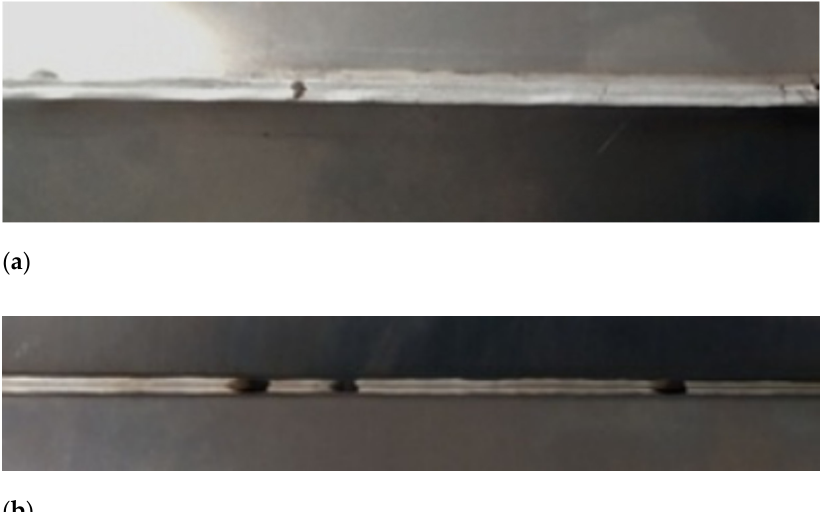
Figure 4. The weld seam top ( a ), and root ( b ) view, ×1.6. Mode parameters: I = 18–24 A; v = 17–18 v = 17–18 mm/s; q = 12–18 mm/s; q = 12–18 lpm.